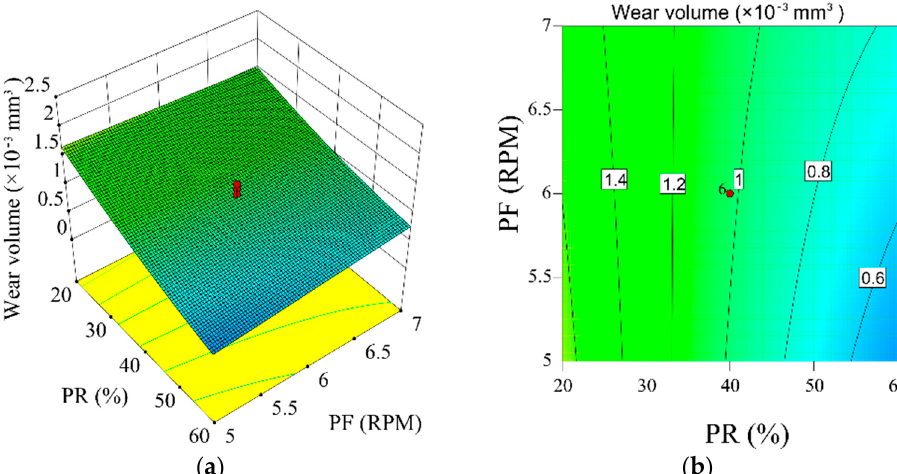
Figure 9. ( a ) 3D response surface showing the influence of the TiC powder rate and the powder feed rate on the wear volume; ( b ) Contour line of the response surface.